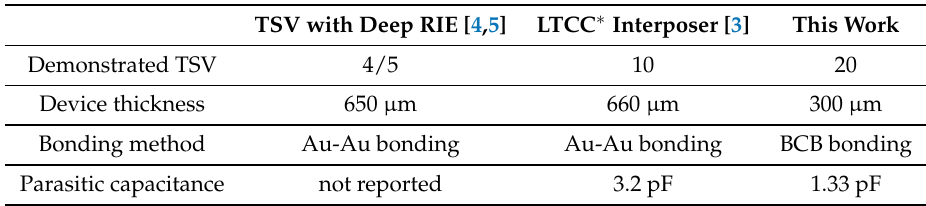
Table 2. Comparison with the previous report for the MEMS–CMOS surface mountable tactile sensor ( ∗ LTCC: Low Temperature Co-fired